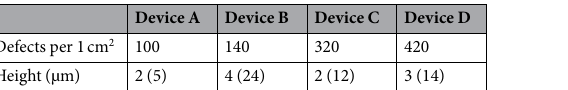
Table 3. Results of particle size analysis carried out on data from surface topographs shown in Fig. 4 (a) to (d). Average values are shown outside and maximum values inside parentheses. Data was thresholded at 1 µ m and image area remained fixed at 13.5 mm 2